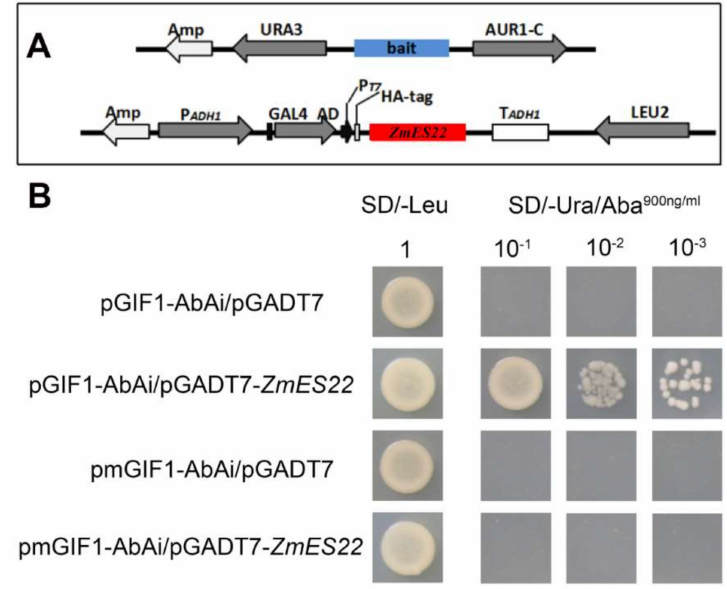
Figure 10. ZmES22 could bind to the core motif of OsGIF1 via yeast one hybrid assay. ( A ) Schematic structure of yeast expression construct pGAD- ZmES22 and reporter construct. ( B ) Yeast Y1HGlod was transformed with the vector pGADT7- ZmES22 and CATGT ( pGIF1 ) or mutant tandem repeats ( pmGIF1 ) plasmids. The transformants were screened by plating on SD/-Leu/AbA plates to verified the interaction between ZmES22 and the core motif of GIF1